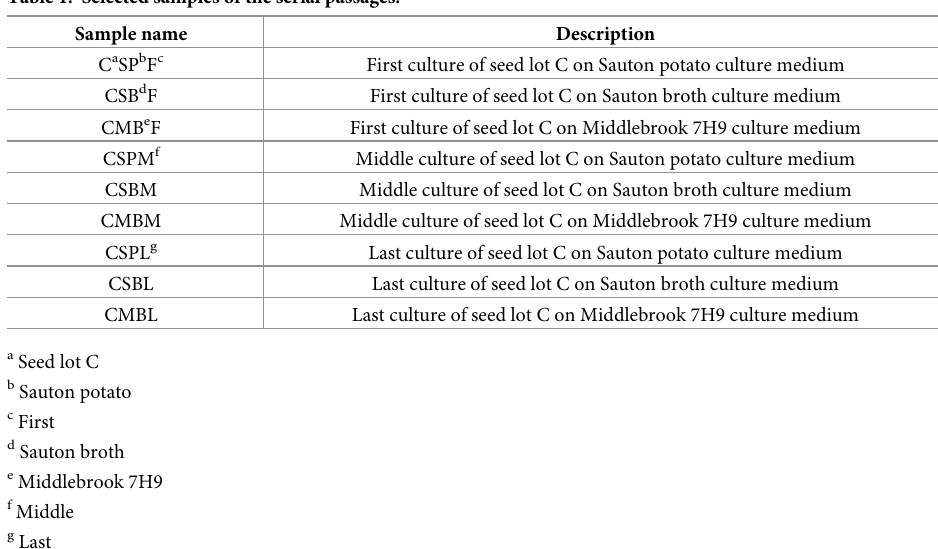
Table 1. Selected samples of the serial passages.